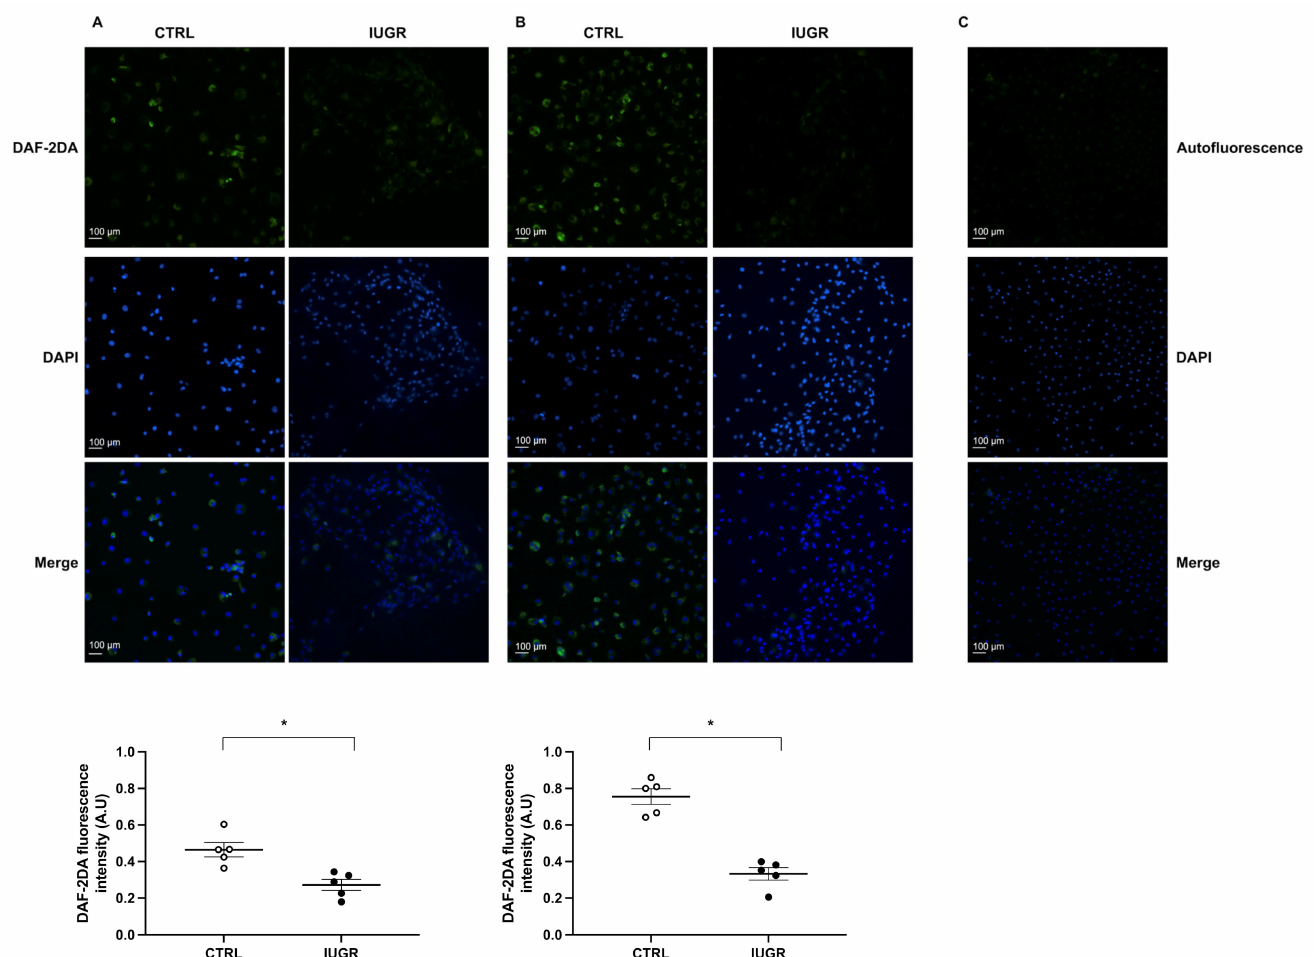
Figure 5. NO production in ECFCs. NO production was evaluated using DAF-2DA in CTRL-ECFCs and IUGR-ECFCs isolated from six-month-old male rats under baseline conditions ( A ) and after stimulation by acetylcholine ( B ). Magnification (20 × ). Nuclei were counterstained with DAPI. An autofluorescence test was performed ( C ). These pictures are representative images from n = 5 animals/group; * p < 0.05. Scale bar = 100 µ